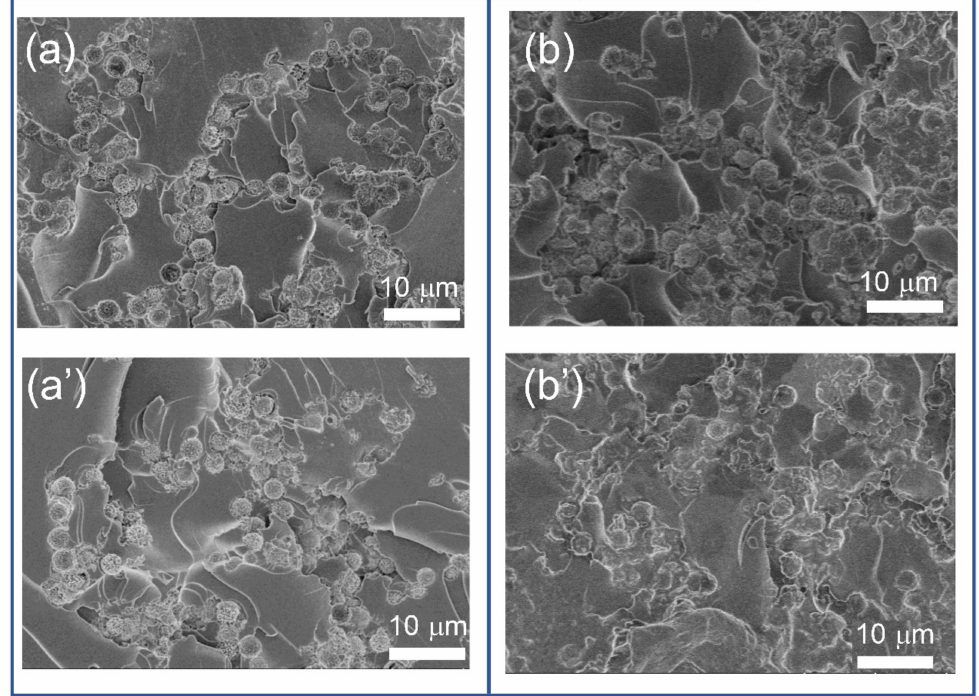
Figure 9. Cross-sectional morphology of Ni@PS/EP composite containing 25 wt.% ( a , a’ ) and 30 wt.% ( b , b’ ) of Ni@PS microspheres ( a , b ) with 300 V/mm of electric field strength, ( a’ , b’ ) without application of electric